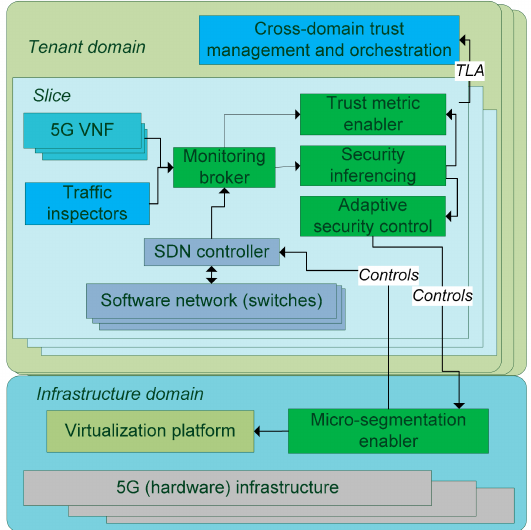
Figure 3. The monitoring framework. VNF: Virtual Network Function; SDN: Software-Defined Network; TLA: Trust Level